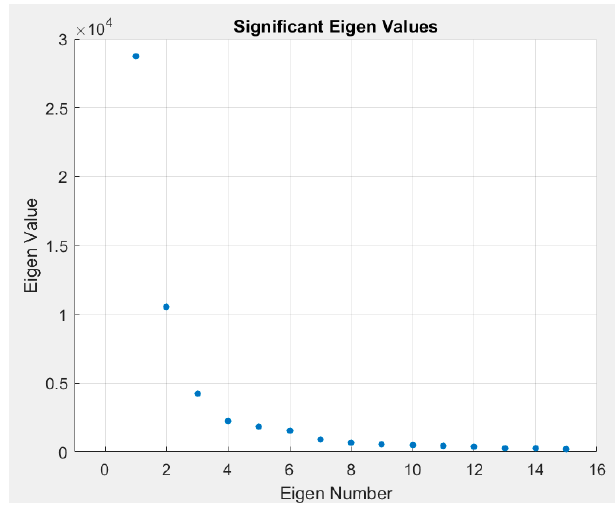
Figure 6. A sample plot of eigen values for each eigen number, obtained from the reconstructed images. Only the first 15 EVs are plotted, as their values significantly diminished to zero beyond that.